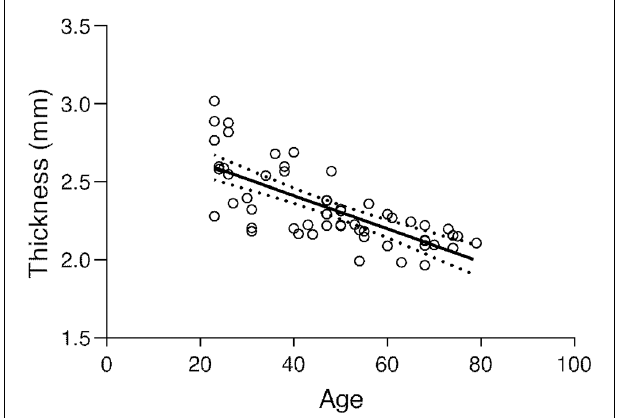
FIGURE 3 | Regression plot of the BA17 thickness vs. age and 95% confidence of the regression slope ( Y = − 0.01062 × X + 2.836; r = − 0.724; p < 0.0001).